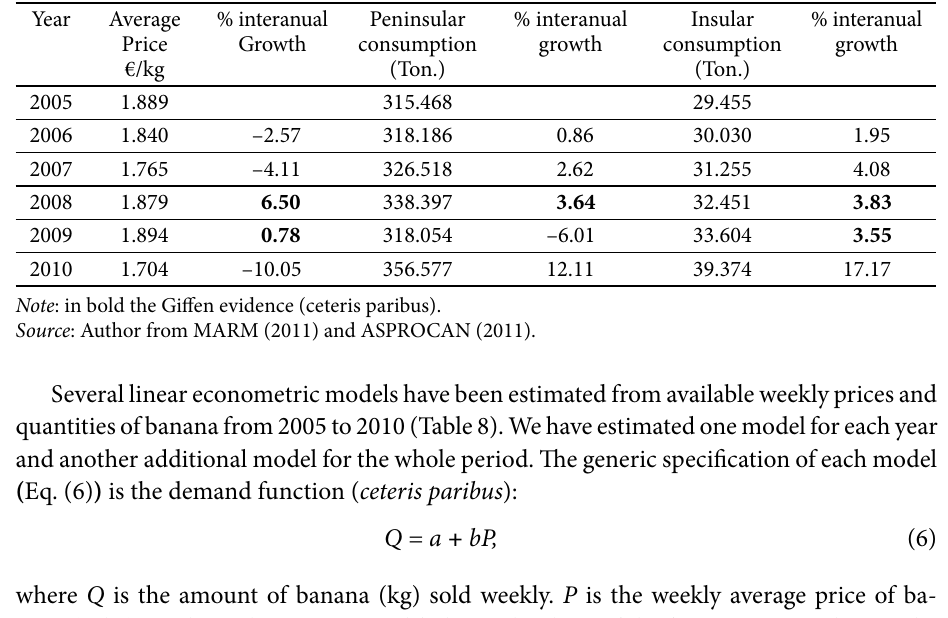
Table 8. OLS estimates of Spanish banana demand function from 2005 to 2010 in ceteris paribus conditions Year Sign of